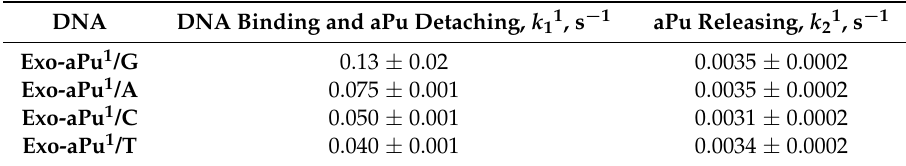
Figure 7. ( a ) A change in the intensity of aPu in the course of APE1 interaction with substrates Exo- aPu 1 /N . ( b ) The values of the observed rate constants k i1 ([APE1] = 1.0 μ M, [ Exo-aPu 1 /N ] = 1.0 μ M). Table 1. The rate constants of the interaction of APE1 with substrates Exo-aPu 1 /N . DNA DNA Binding and aPu Detaching, k 11 , s − 1